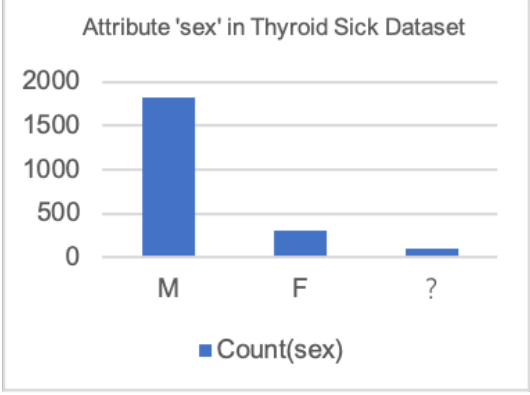
Figure 9. SEX Attribute in Thyroid Sick Dataset